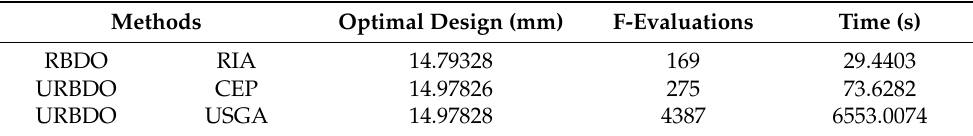
Table 3. Comparison of optimal solutions for brake system problem.